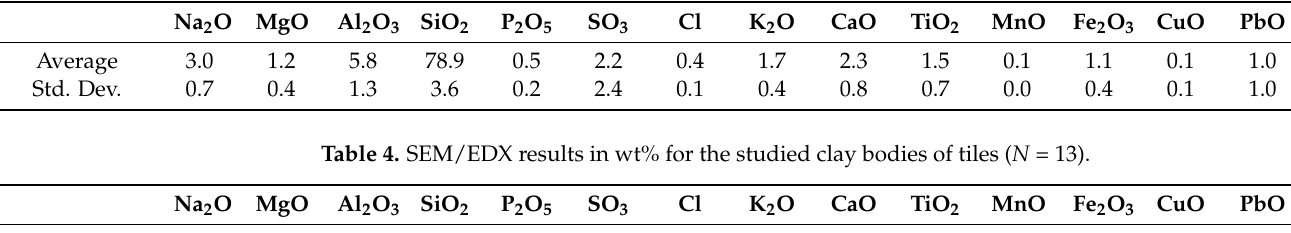
Figure 1. Dendrograms of cluster analyses of glazes and bodies based on qualitative XRF analysis. Table 3. SEM/EDX results in wt% for the studied stonepaste bodies of tiles ( N = 19).